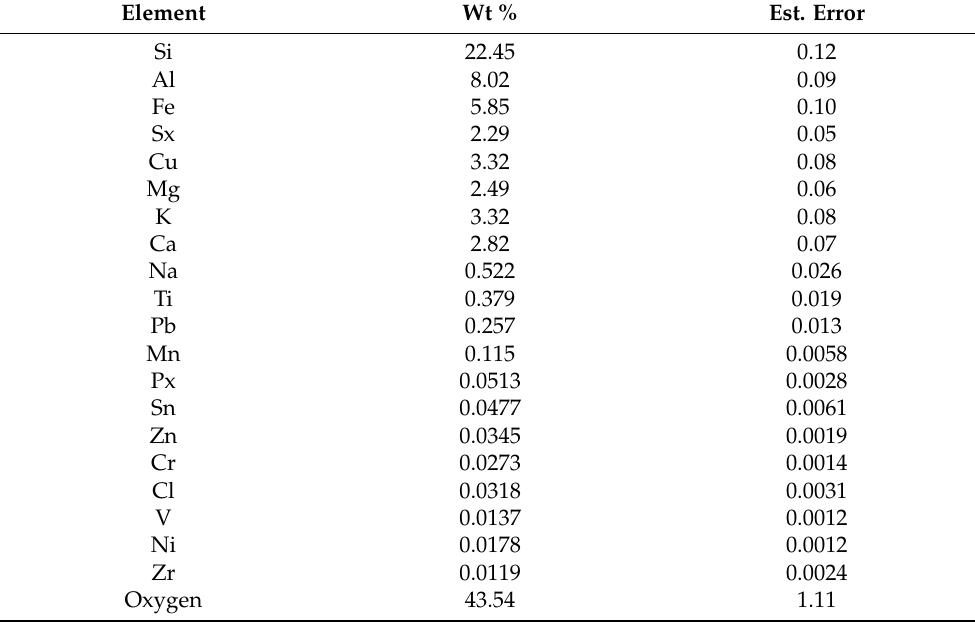
Table 4. X-ray fluorescence of the San Andr é s waste